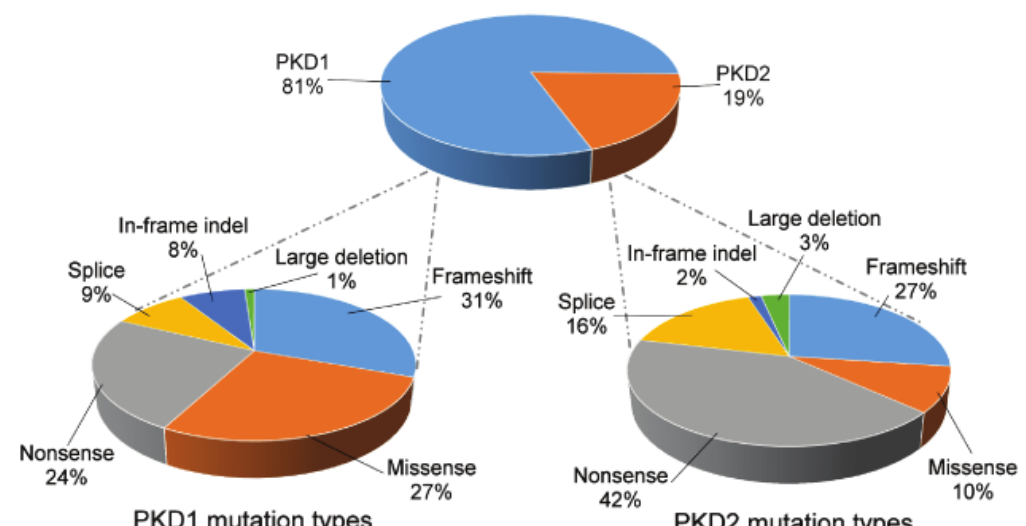
Figure 2. Frequency and type of PKD1 and PKD2 mutations from the PKD mutation database. All mutation types have been reported for both genes. The relative infrequency of missense mutations and in-frame insertions or deletions for PKD2 could reflect the under-diagnosis of these patients present in the general population. The PKD mutation database is available at http://pkdb.mayo.edu/index.html (accessed 22 April